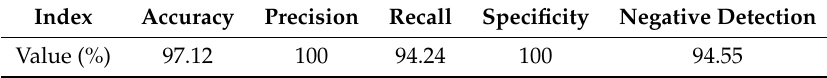
Table 13. Detection evaluation indices.